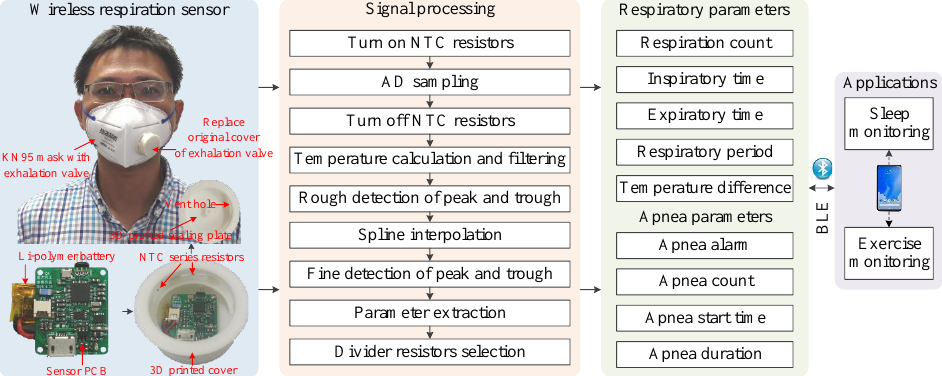
Figure 3. The system architecture of wireless respiration